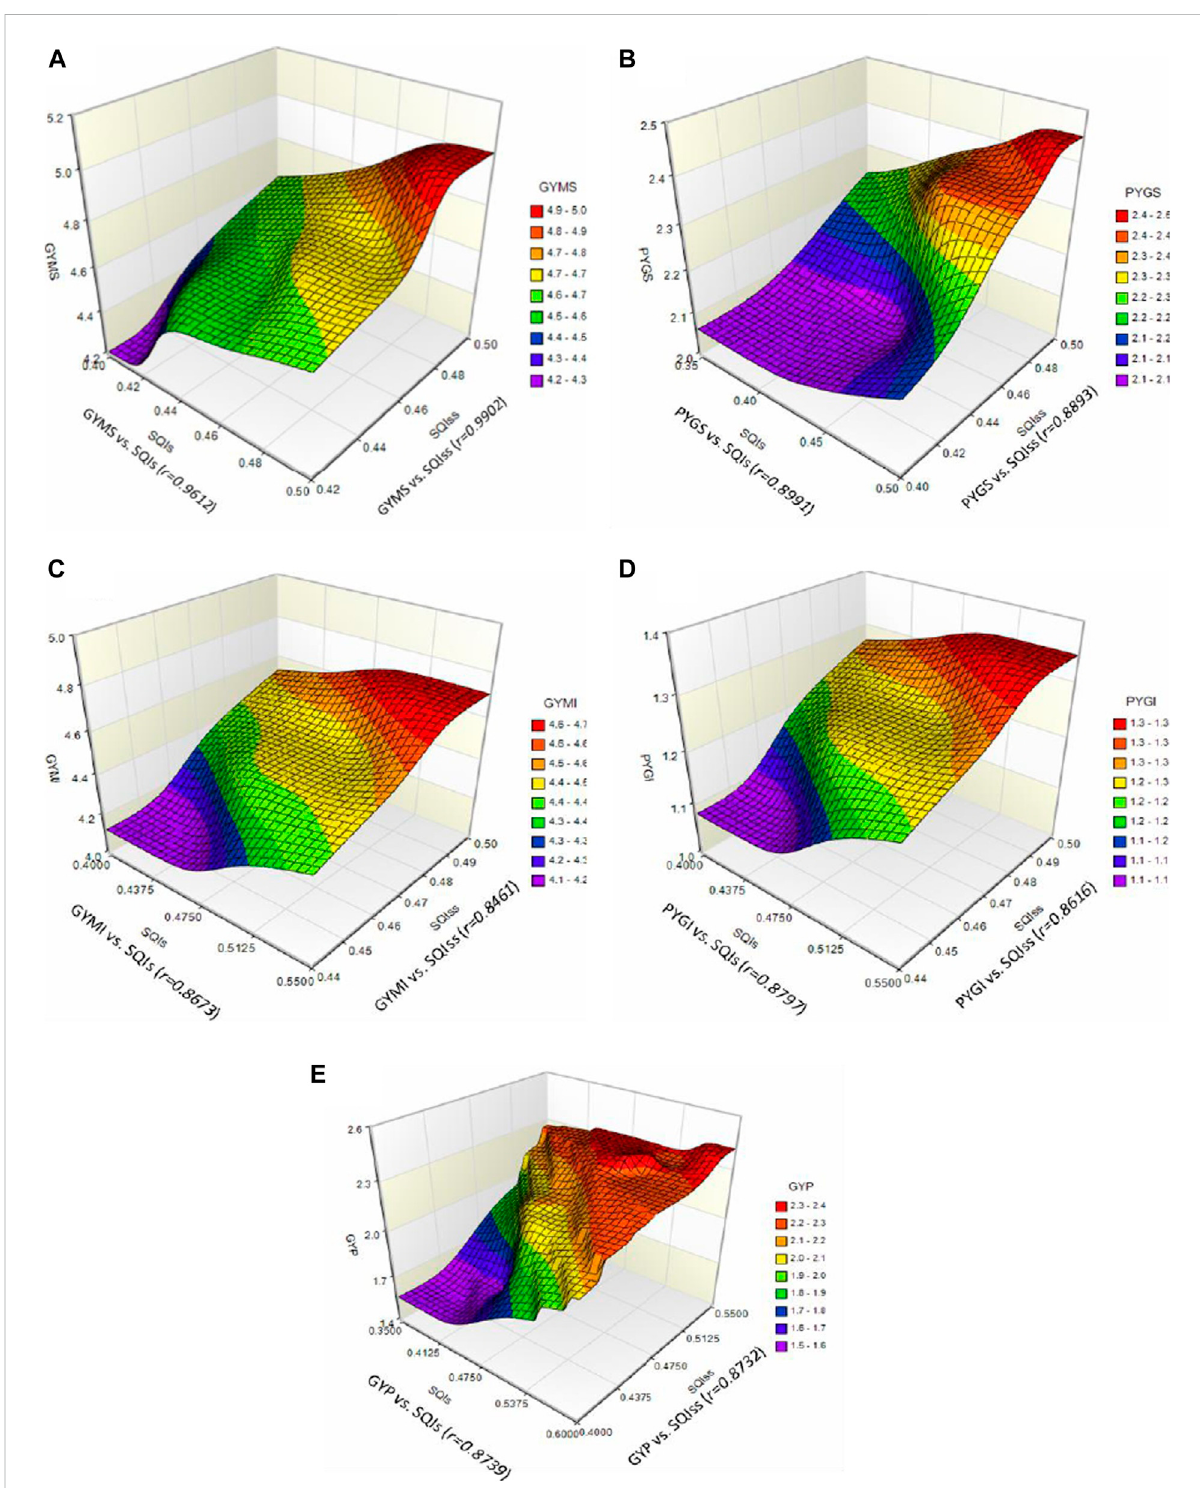
FIGURE 6 3Dsurfaceplotsofrelationship(r)betweensoilqualityindexofsoil(SQIs,0 – 0.15 m)andsubsurfacesoil(SQIss,0.15 – 0.45 m)withmeanmaize/ groundnut yield after fi ve years of experimentation, (A) grain yield of maize sole crop (GYMS, Mg ha -1 ), (B) pod yield of groundnut sole group (PYGS, Mgha -1 ), (C) grainyieldofintercroppedmaize(GYMI,Mgha -1 ), (D) podyieldofintercroppedgroundnut(PYGI,Mgha -1 ), (E) grainyieldofpea(GYP,Mg ha -1